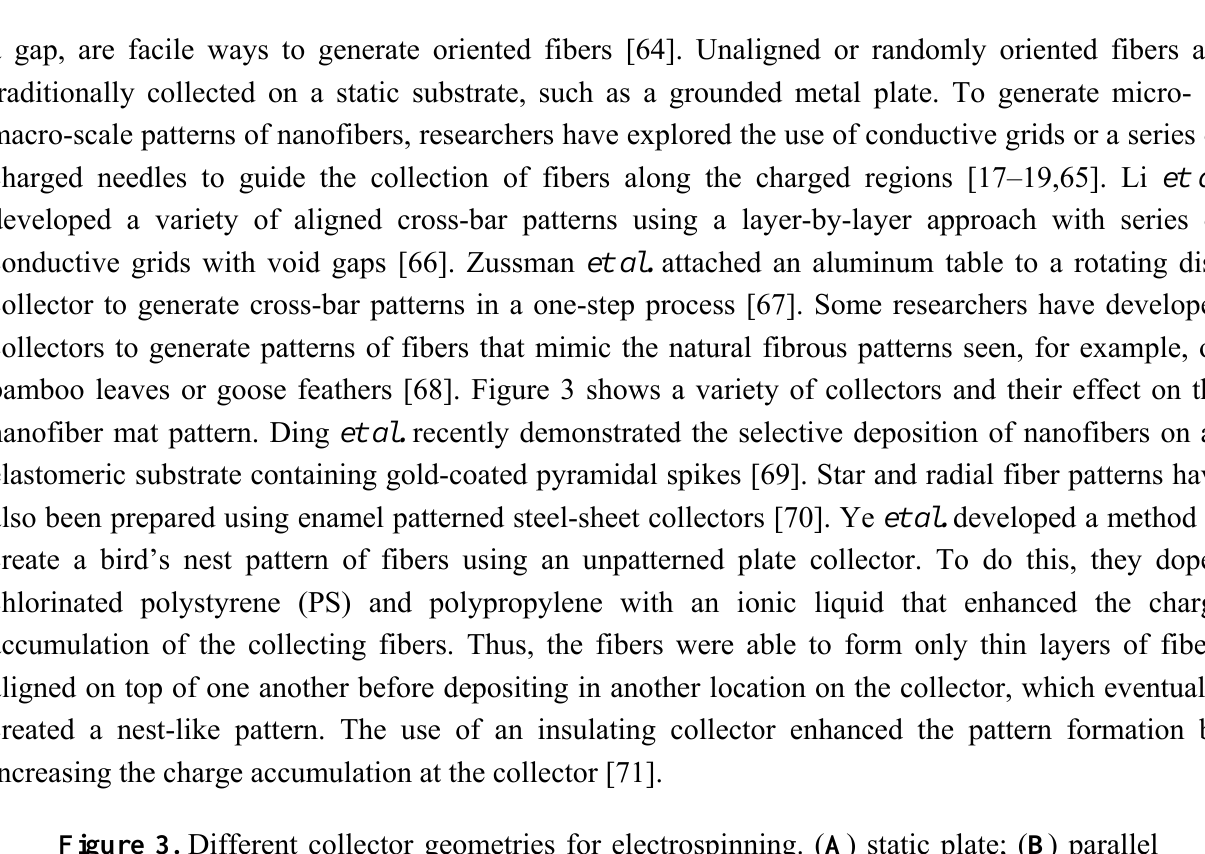
Figure 3. Different collector geometries for electrospinning. ( A ) static plate; ( B ) parallel electrodes; ( C ) rotating disk; ( D ) rotating mandrel; ( E )